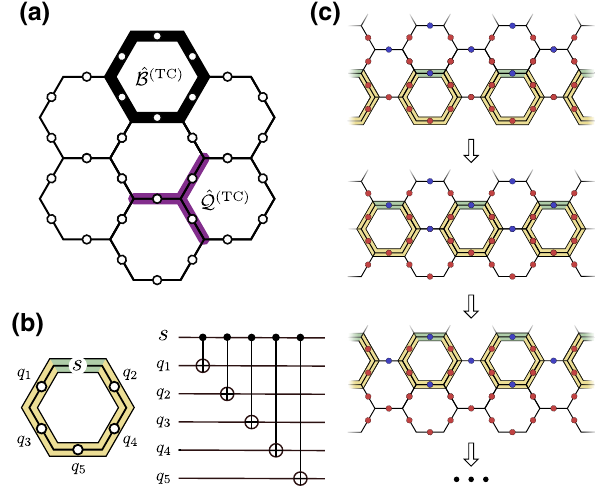
FIG. 1. The construction of the toric code ground state. (a) The honeycomb lattice with qubits on the edges that contains a pla- quette (black) and a vertex (purple): the vertices on the boundary only have two incoming legs. (b) The quantum gate C- ˆ B p that is controlled by the representative qubit and targets the rest. The green marks the control qubits (unchanged upon C- ˆ B p ), while the yellow marks the target qubits (changed). (c) A graphical illus- tration of the algorithm: prepare the red qubits in | 0 (cid:3) and the √ 2; then apply C- ˆ B p on each blue qubits in |+(cid:3) = ( | 0 (cid:3) + | 1 (cid:3) )/ plaquette in parallel for each